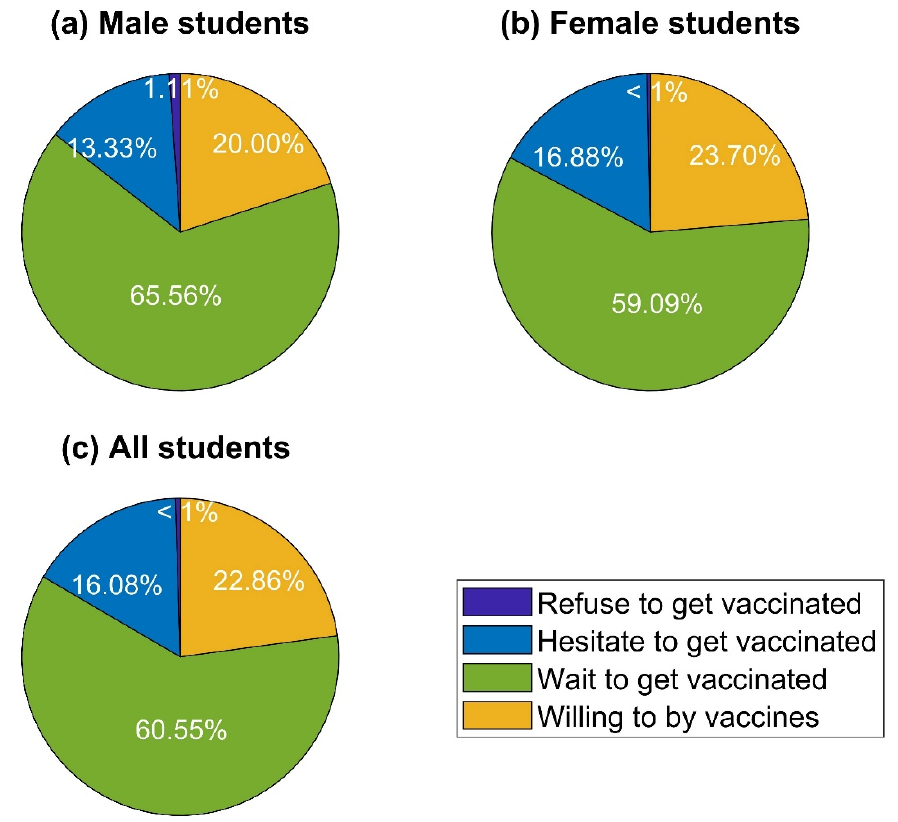
Figure 2. Respondents’ intent to participate in COVID-19 vaccination.